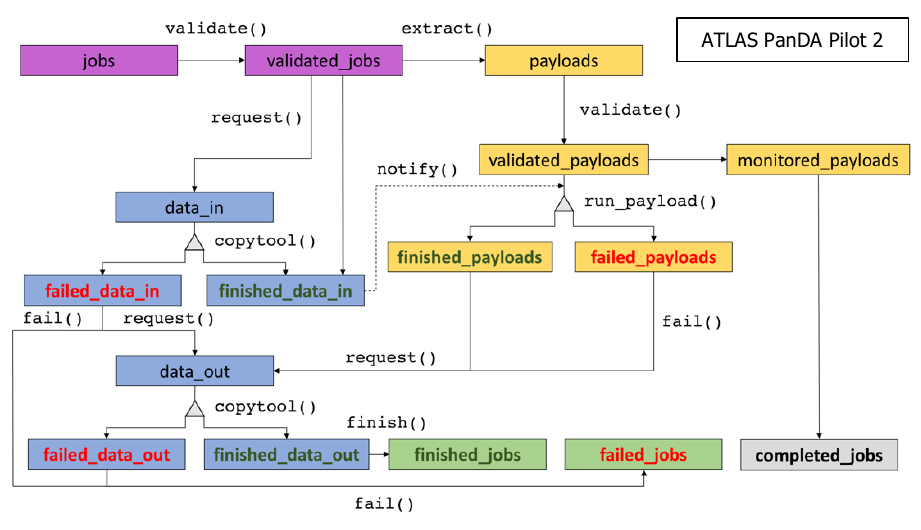
Fig. 1. The internal generic flow of job objects. A downloaded job is inserted into the jobs queue and ends up in either the finished_jobs or failed_jobs queue. The completed_jobs queue contains a copy of a job object that has completed running (finished or failed) and is used for internal